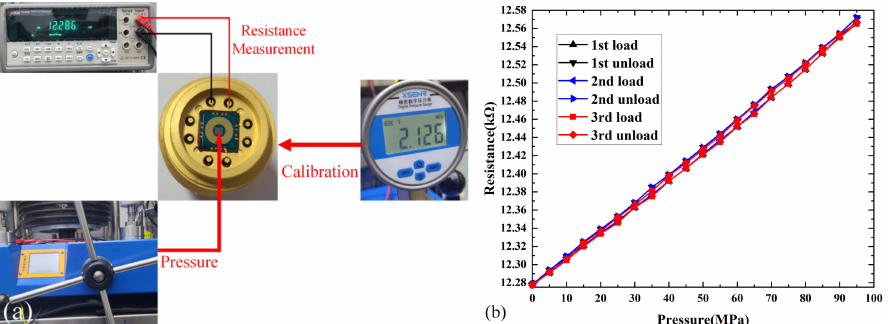
Figure 16. Electromechanical characteristics of the pressure sensor. ( a ) The schematic diagram for graphene pressure sensor measurement. ( b ) Relationships between the pressure and resistance for three